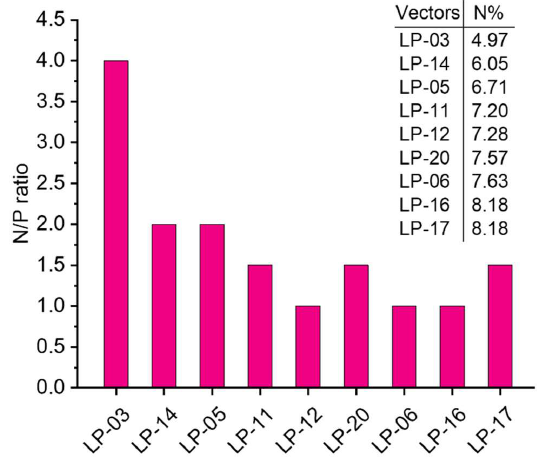
Figure 5. Relation between N/P ratio at which complete DNA retardation was observed and the nitrogen content (N%) of lignin-PDMAEMA graft polymer. Data for LP-14 and LP-16 were reported previously [18].